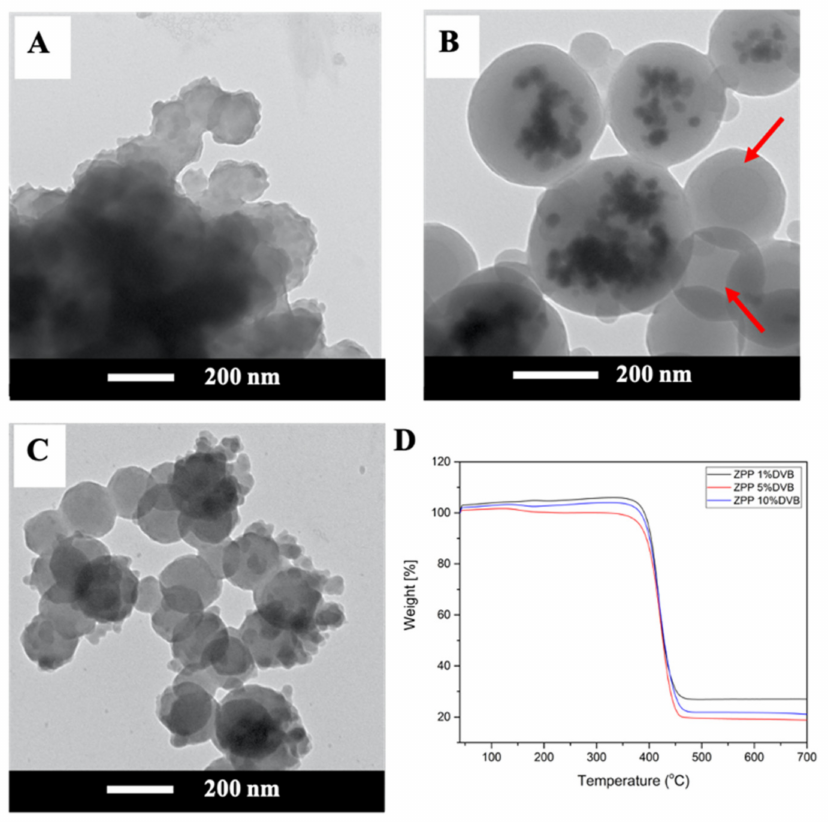
Figure 4. TEM images of spherical ZPPs by varying DVB from ( A ) 1, ( B ) 5, and ( C ) 10%. and ( D ) the TGA